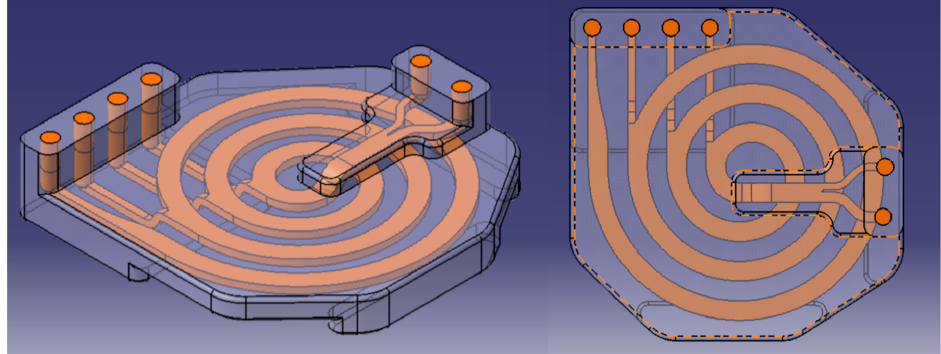
Figure 10. Three ‐ dimensional model and top view of the printed millifluidic chip. The sorting device features two inlets, one for the buffer and one for the samples to be sorted. During the passage, the particles are deflected into four different outlets.